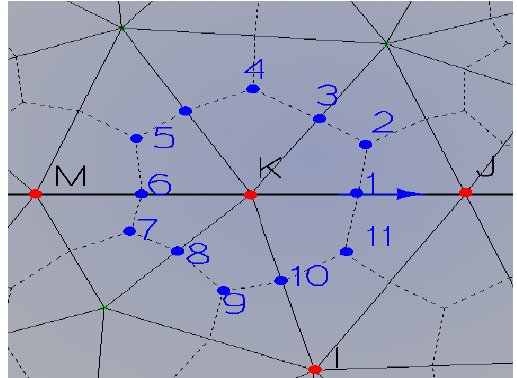
Figure 2. Dual barycentric